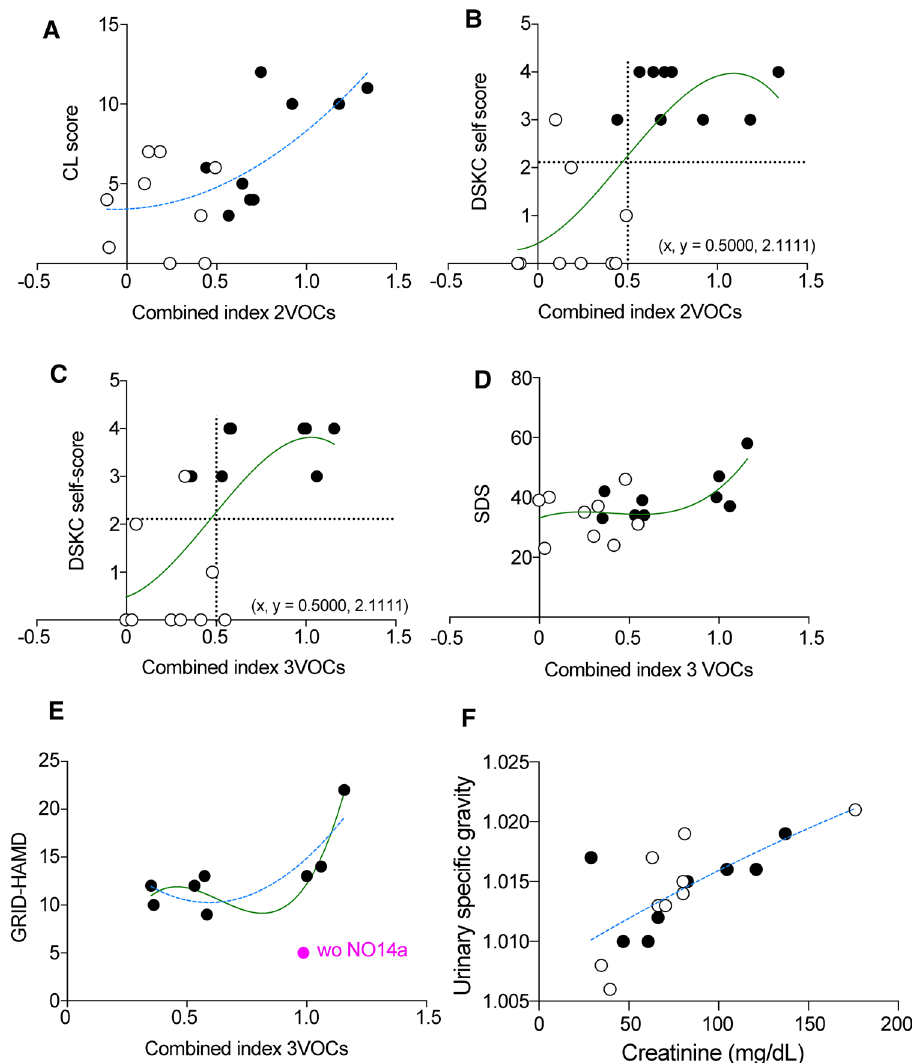
Fig. 4 Curve fit to estimate the relationship between cohort assessments and combined three- or two-volatile organic compound indi- ces. The curve estimations showed significant Pearson’s correlations between cohort assessments and combined volatile organic com- pound (VOC) indices. Major depressive disorder and/or agoraphobia positive (black circles) and negative persons (white circles). Quad- ratic (dotted blue lines) and cubic (green lines) polynomial curves were fitted. The formulae and the corresponding r -values and p -values were analyzed using Prims 8 and SPSS, respectively. Formulae, r- and p -values: Y = 3.423 + 0.560*X + 4.335*X 2 , r = 0.660, F(2, 17) = 5.781, p = 0.014 in ( a ); Y = 0.420 + 1.853*X + 5.567*X 2 -3.924*X 3 , r = 0.709, F(3, 17) = 4.708, p = 0.018 in ( b ); Y = 0.483 + 1.317*X + 6.894*X 2 -4.882*X 3 , r = 0.661, F(3, 17) = 3.621, p = 0.040 in ( c ); Y = 33.109 + 19.639*X-58.487*X 2 + 48.613*X 3 , r = 0.637, F(3, 17) = 3.190, p = 0.057 in ( d ); Y = 20.150– 33.282*X + 28.014*X 2 , r = 0.839, F(2, 7) = 5.964, p = 0.047 in ( e ) (blue dotted line); Y = -13.614 + 137.017*X-233.638*X 2 + 122.438*X 3 , r = 0.945, F(3, 7) = 11.033 , p = 0.021 in ( e ) (green line); Y = 1.008 + 9.312e−005*X-9.005e−008*X 2 , r = 0.709, F(1, 17) = 16.138, p = 0.001 in ( f ). The black dotted lines show the mean values in the vertical and horizontal lines in ( b , c ). While the correlations in ( a – d ) and ( f ) included a subject (No. 14a) exhibiting agoraphobia but no depressive symptoms, the correlation in ( e ) did not include this subject. Kihon CL score Kihon Checklist that consists of 20 items [14]; SDS Zung Self-Rating Depression Scale, GRID-HAMD GRID-Hamilton Rating Scale for